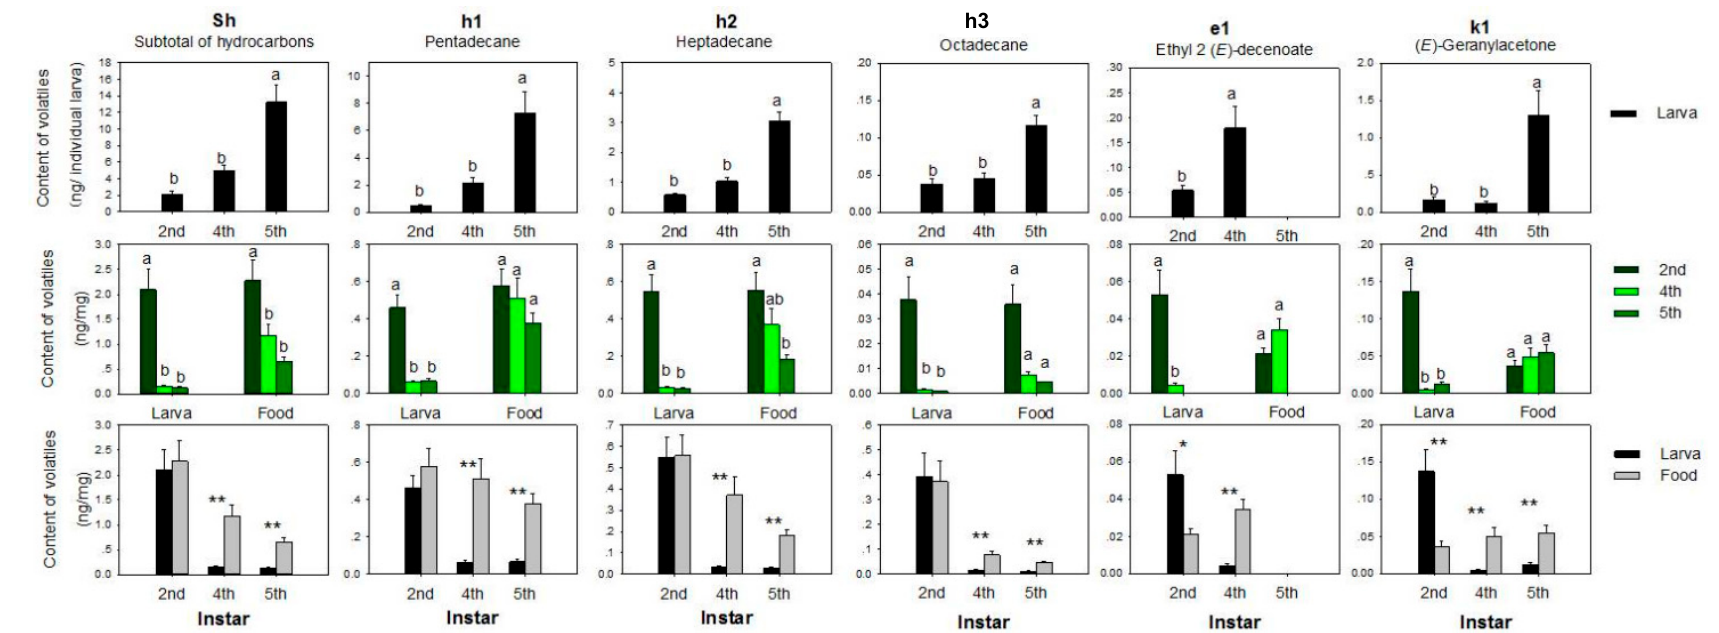
Figure 4. Hydrocarbons and other minor volatiles extracted from larvae and larval food at different larval instars. N > 10 for each group; error bars represent standard errors, different letters and ‘*’ on top of bars denote significant difference at the level of 0.05, ‘**’ at the level of 0.01 under Fisher’s PLSD test, after ANOVA showed a significant effect. Bars sharing a superscript letter are not significantly different.